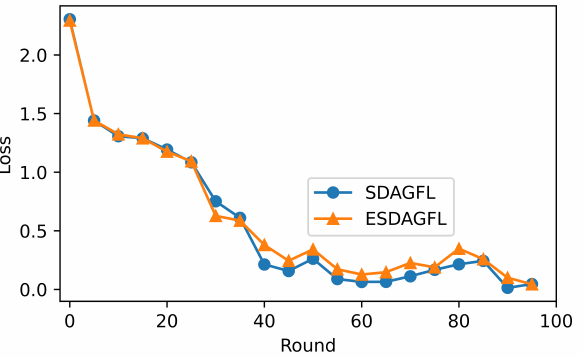
Figure 4. The average training loss of ESDAGFL and SDAGFL evaluated on the FMNIST- clustered dataset.